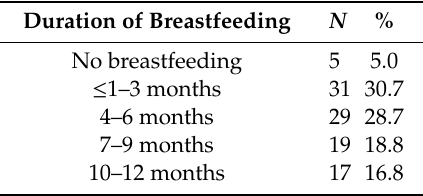
Table 2. Distribution of breastfeeding duration ( n = 101).